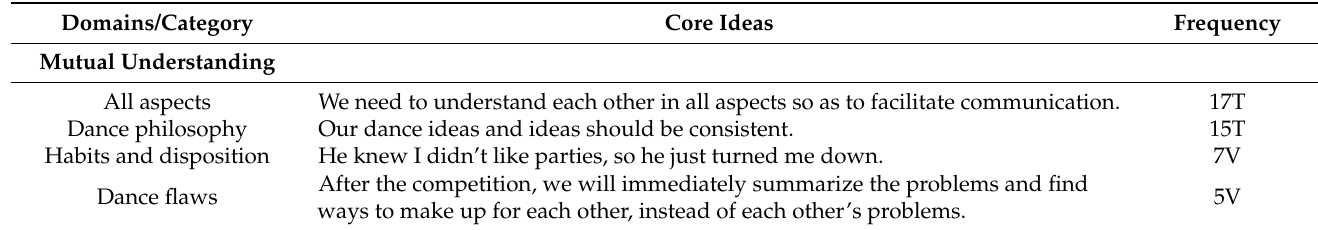
Table 2. Domains and